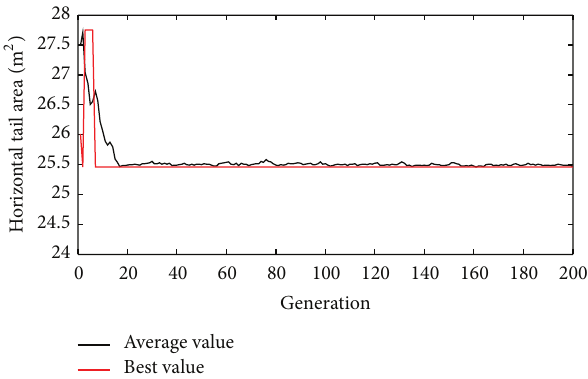
Figure 5: Best and average wing aspect ratio (m) versus generation.